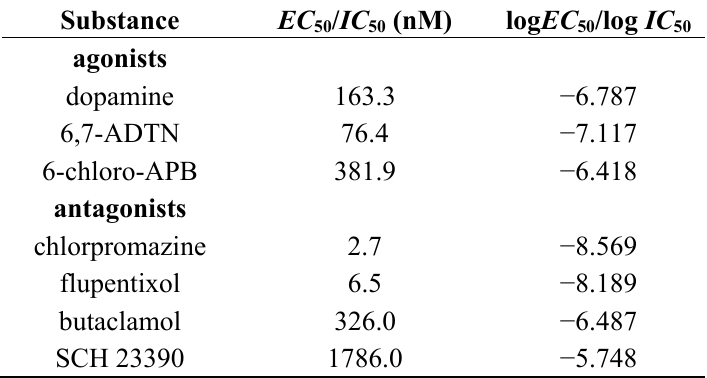
Table 1. Agonist ( EC PeaDOP2A receptor. For each substance, EC dose-response curves and are listed in order of their potency in increasing [cAMP] blocking dopamine (300 nM)-induced cAMP increase,